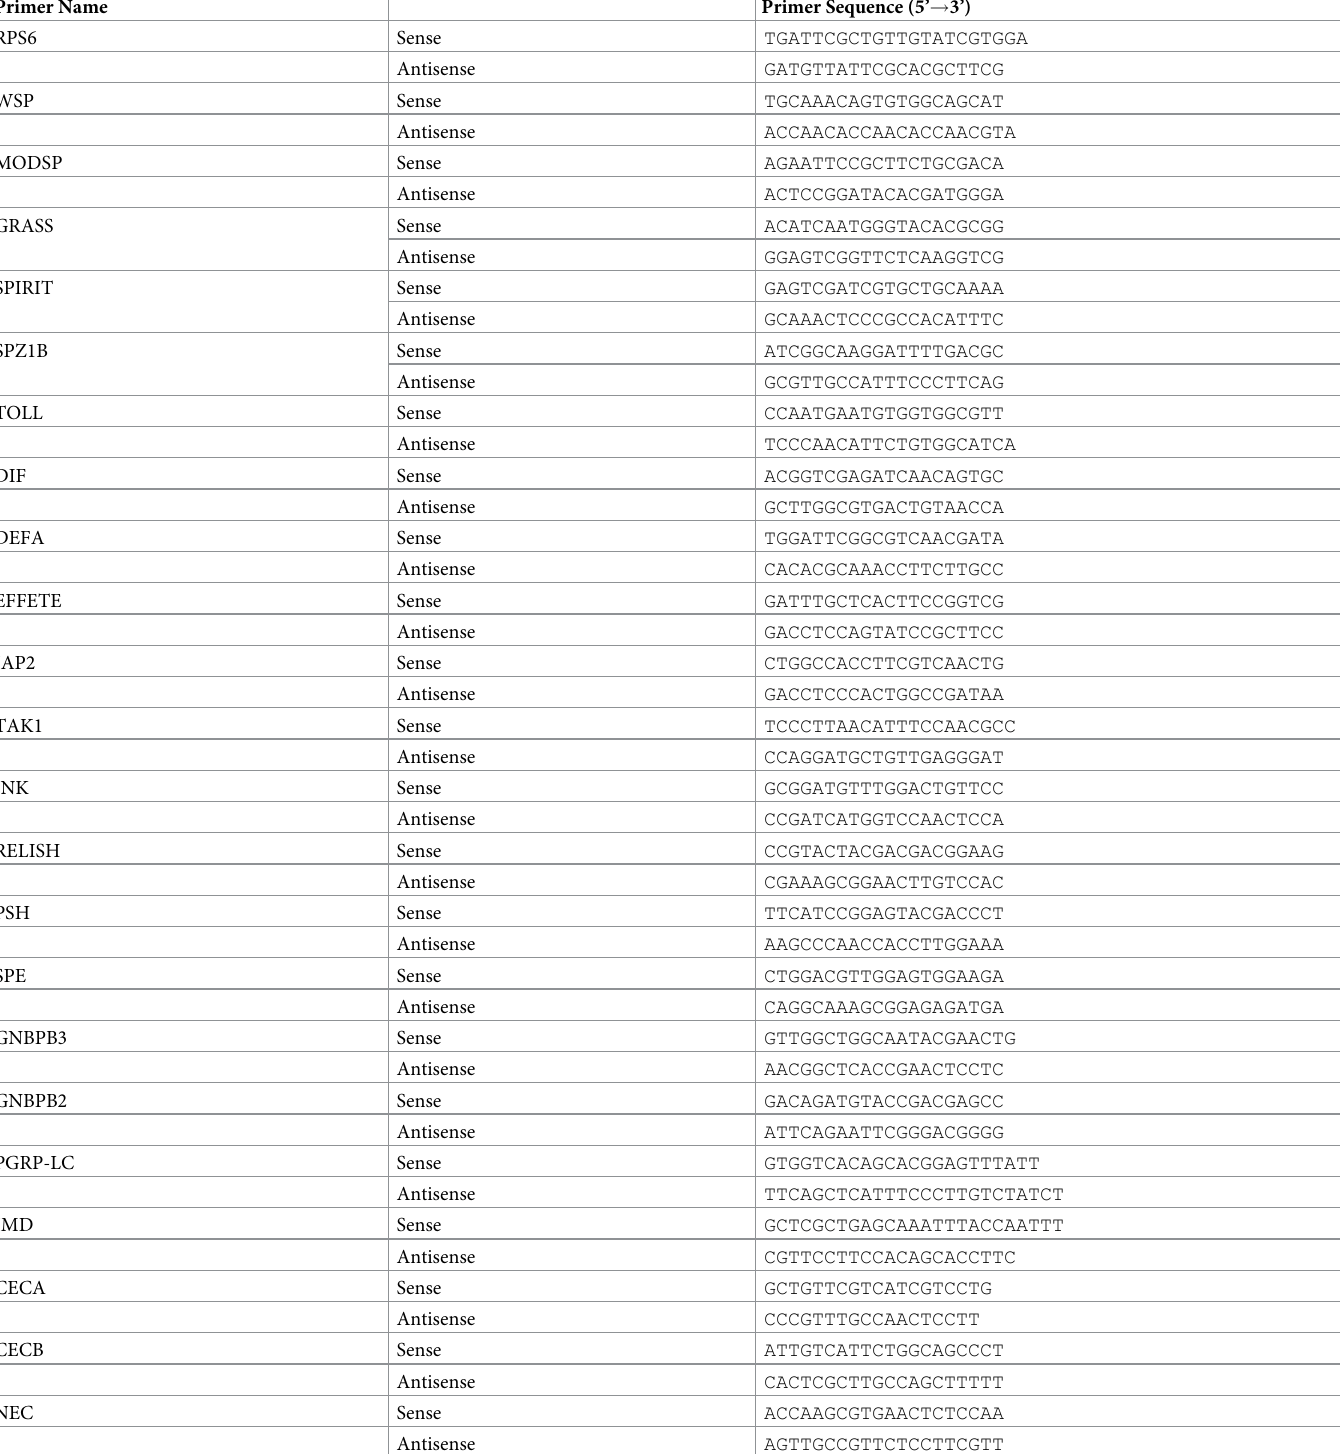
Table 1. Primer sequences used in real-time quantitative